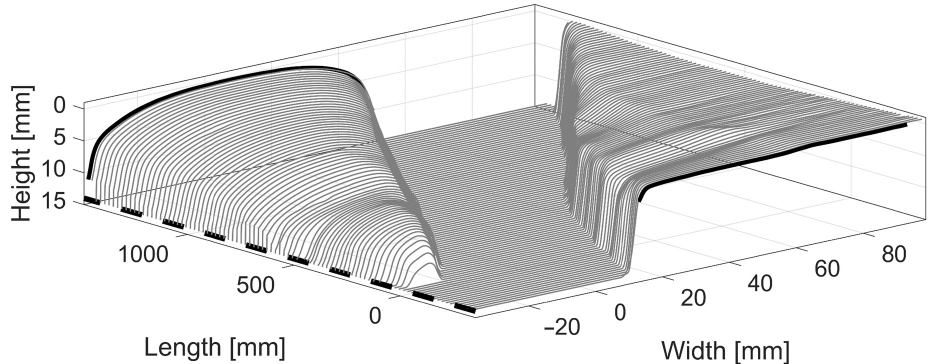
Figure 4. Post-processed, 2D, cross-section profiles ready for MBS analysis, crossing panel VAD 131. The longitudinal spacing between profiles is 10 mm. The crossing nose is to the left in the figure and the wing rail is to the right.